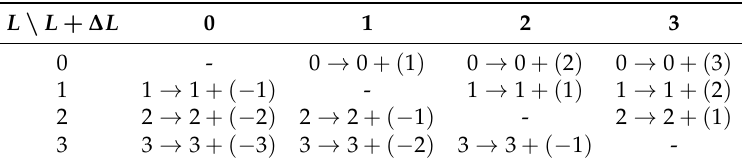
Table 1. Simulated working load change of L → L + ∆ L